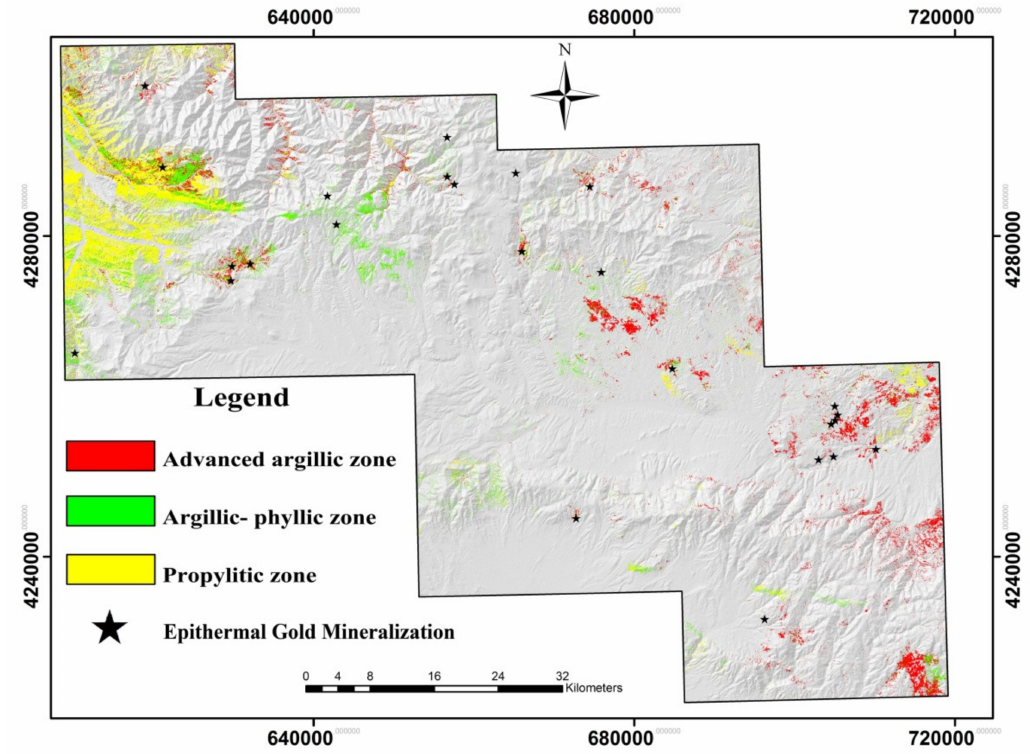
Figure 11. The PCA image-map derived from ASTER selected PCAs for mapping advanced argillic, argillic-phyllic and propylitic alteration zones in the study area that overlaid on hill